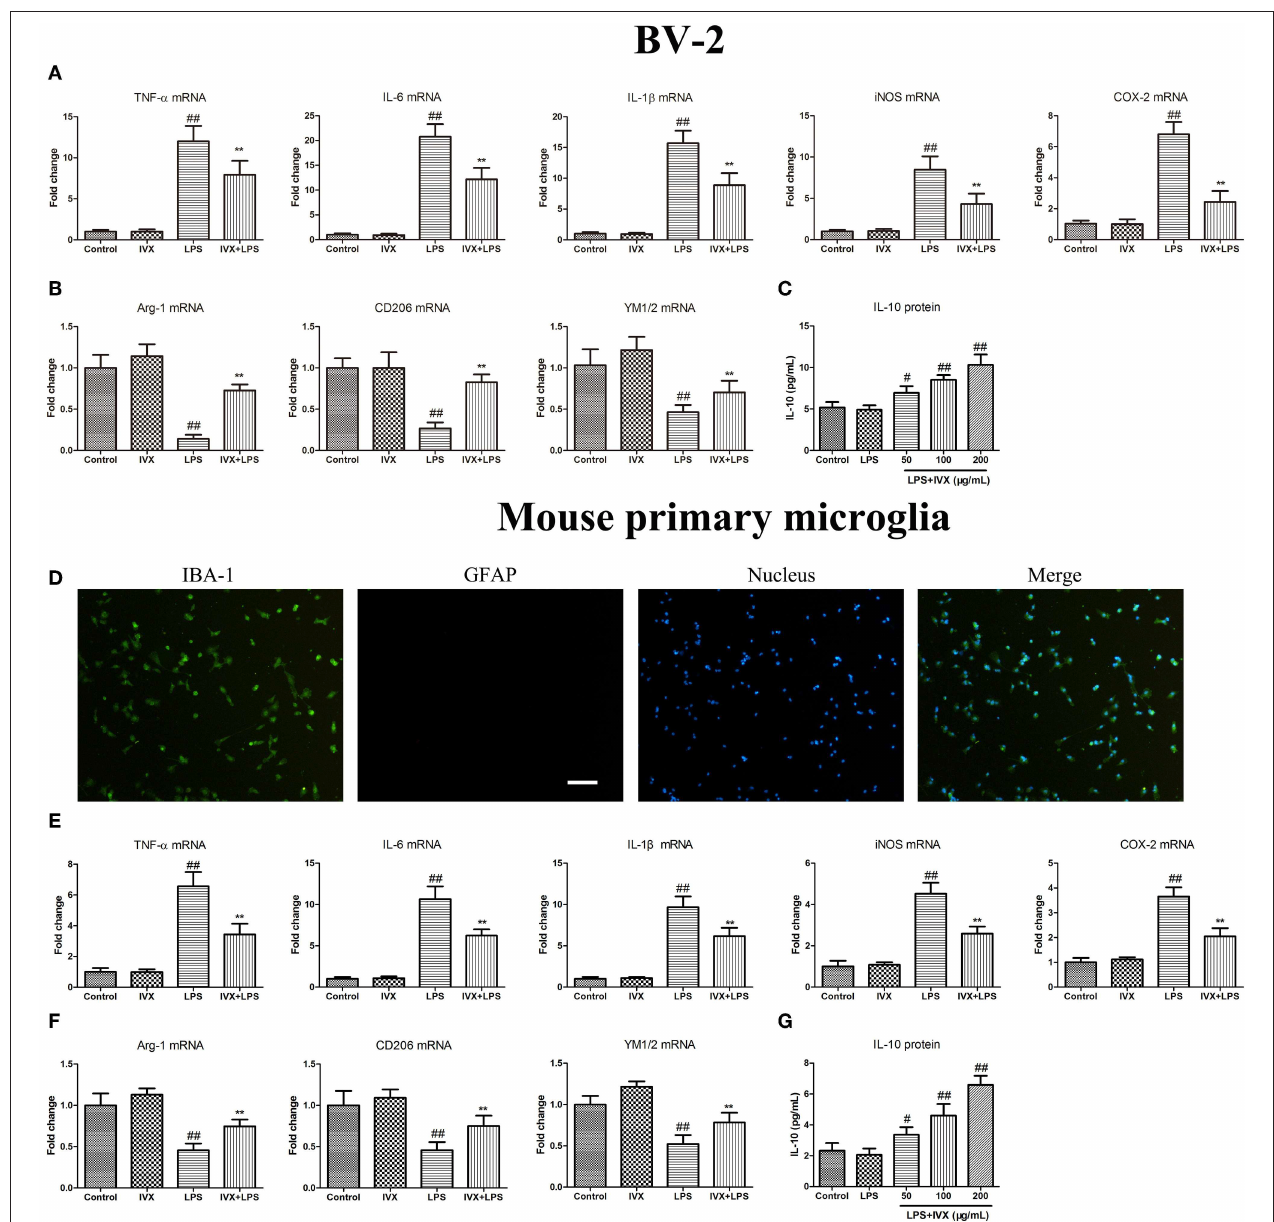
FIGURE 1 | Isovitexin (IVX) inhibited M1 microglial polarization and promoted M2 microglial polarization in LPS-activated BV-2 cells and mouse primary microglia. (D) The purity of mouse primary microglia was detected by Fluorescent immunocytochemistry. BV-2 cells and mouse primary microglia were pretreated with IVX (200 µ g/mL) for 2h and then treated with LPS (100ng/mL) for 6h and 24h. After 6h, cells were then harvested and the mRNA expression of M1 microglial markers (TNF- α , IL-6, IL-1 β , iNOS, and COX-2) and M2 microglia markers (Arg-1, CD206, and YM1/2) were detected by RT-PCR. (A,E) IVX inhibited the mRNA expression of M1 microglial markers (TNF- α , IL-6, IL-1 β , iNOS, and COX-2) in LPS-activated BV-2 cells and mouse primary microglia. (B,F) IVX attenuated the decrease of M2 microglial markers (Arg-1, CD206, and YM1/2) in LPS-activated BV-2 cells and mouse primary microglia. After 24h, cells medium were harvested and the release of IL-10 were investigated by ELISA. (C,G) IVX enhanced the release of IL-10 in LPS-activated BV-2 cells and mouse primary microglia. The experiments were conducted in triplicate and repeated at least three times. Values are expressed as mean ± SEM ( n = 4 in each group). # p < 0.05 , ## p < 0.01, vs. control group; ** p < 0.01 vs. LPS